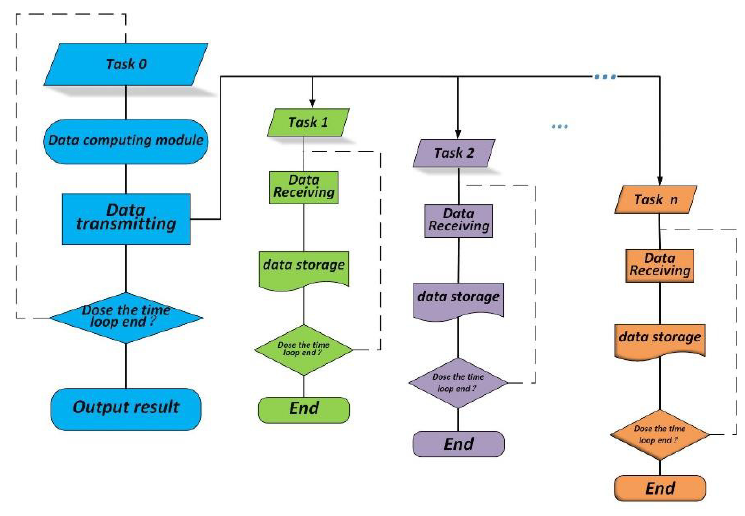
Figure 5. Storage module